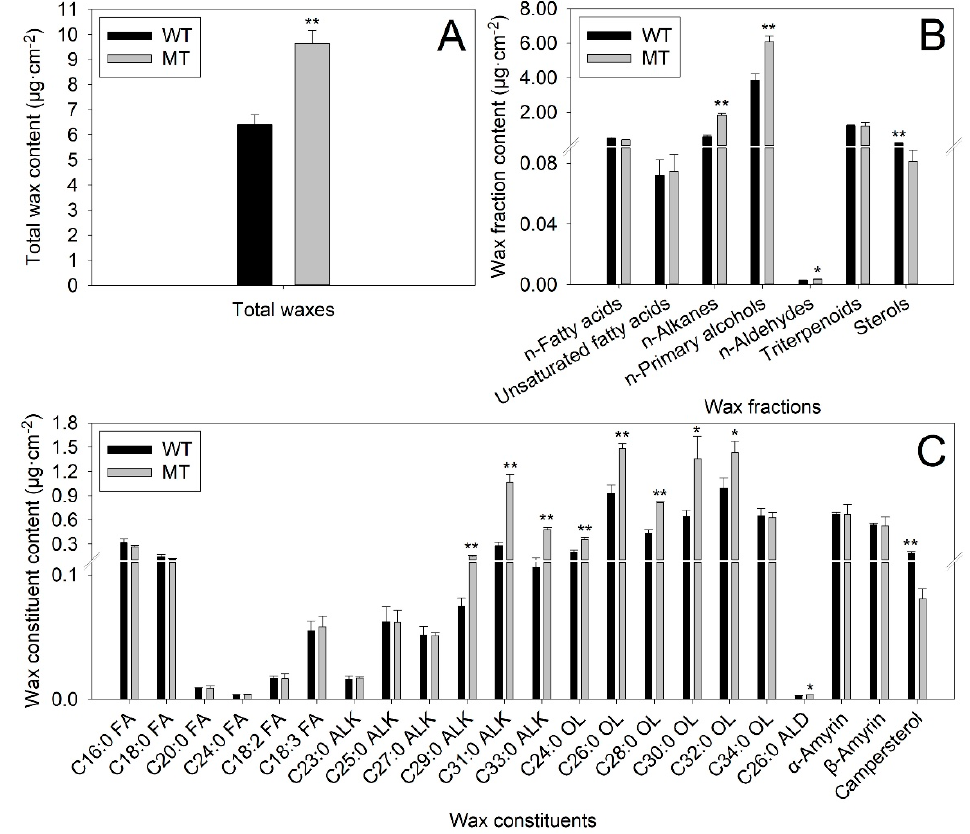
Figure 3. The contents of total waxes ( A ), wax fractions ( B ) and wax constituents ( C ) in WT and MT leaves. Abbreviations of the wax fractions are listed as follows: FA, fatty acid; ALK: alkane; OL: alcohol; ALD: aldehyde. Vertical bars represent standard deviations of the means ( n = 3). Significant differences between WT and MT leaves at the p < 0.05 and p < 0.01 levels were indicated by * and **, respectively, according to Student’s t − test.